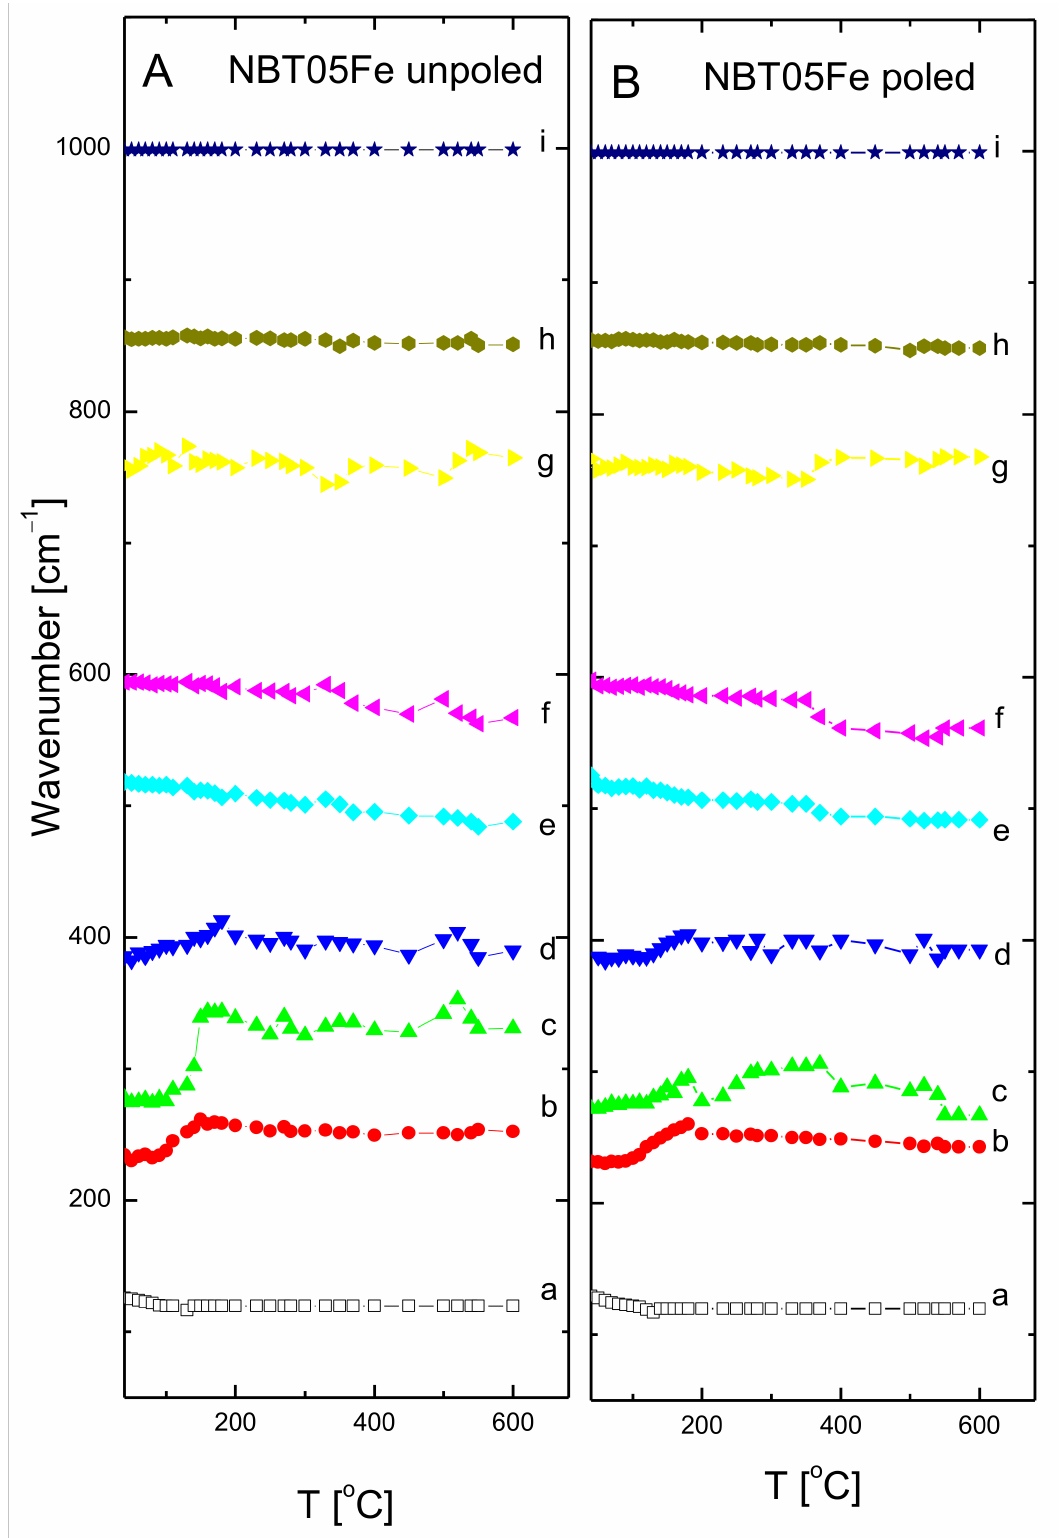
Figure 9. The temperature evolution of mode wavenumbers of unpoled and poled NBT05Fe. The same names for particular mode as in insert of Figure 7 are used. The a, b, c, d, e, f, g, h and i are mode